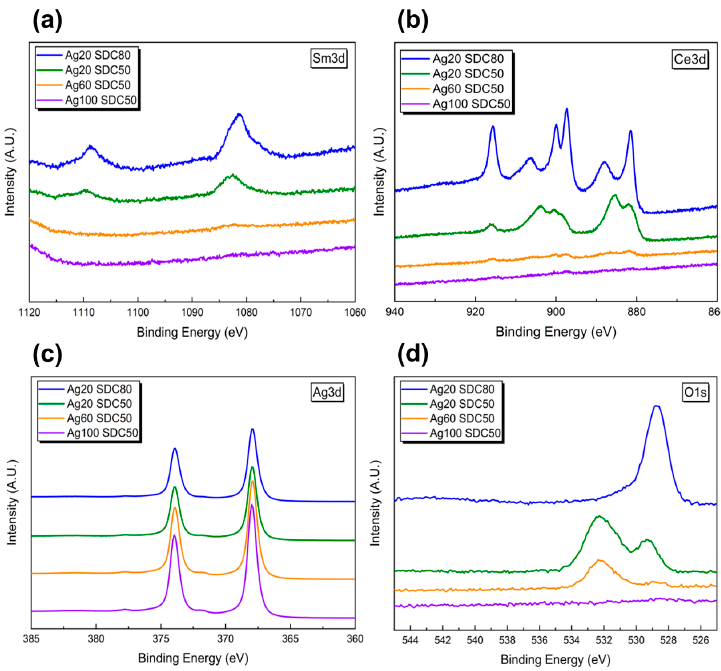
Figure 2. The XPS spectra of the ( a ) Sm3d, ( b ) Ce3d, ( c ) Ag3d and ( d ) O1s for various Ag-SDC cermet cathodes.